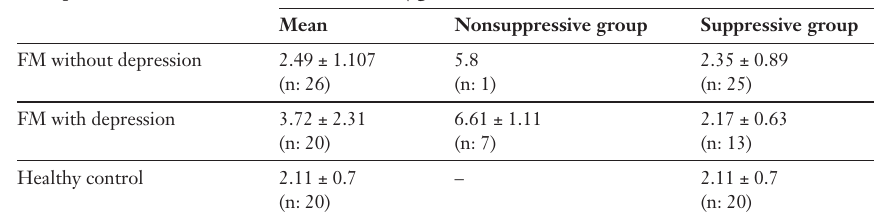
DST results in study groups.